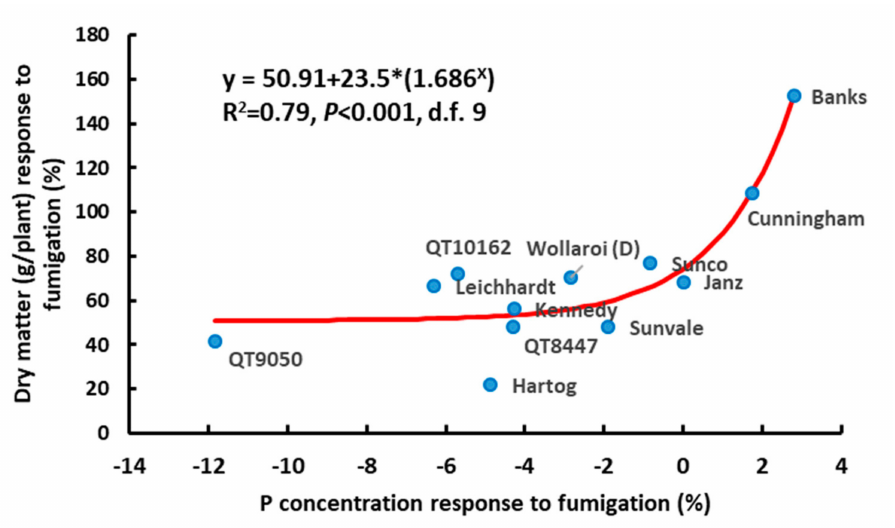
Figure 8. Relationship between percentage response to fumigation of plant dry matter at Z32 (stem elongation) and percentage response to fumigation of phosphorus concentration in Experiment 3 of wheat and durum (D)